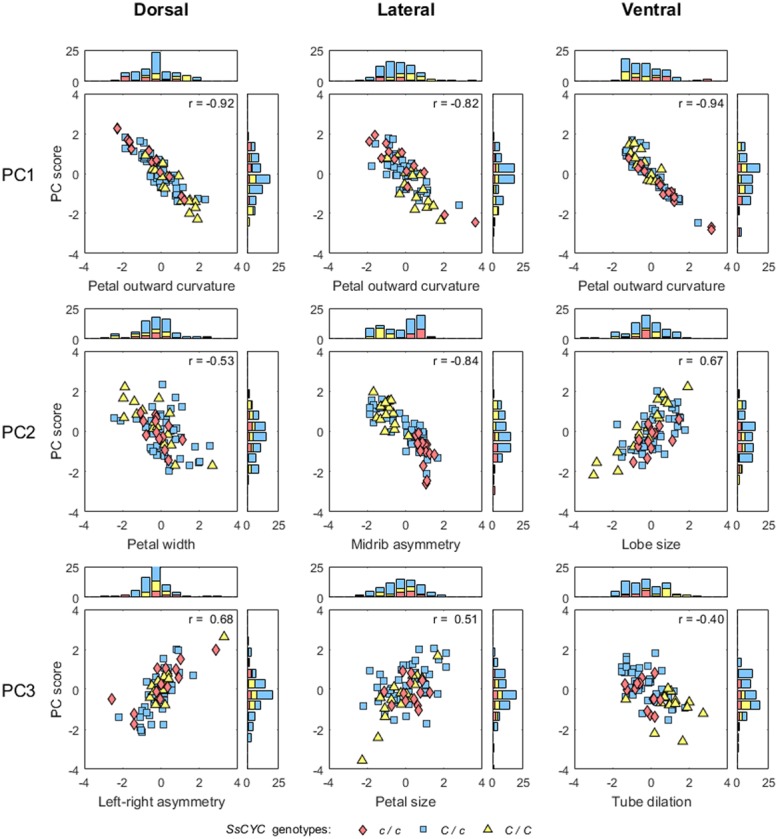
Scatter plots and histograms of the PC scores and defined traits. The PC scores and trait values are standardized. The correlation coefficients of the PC scores and trait values are provided at the upper right corners of the scatter plots.